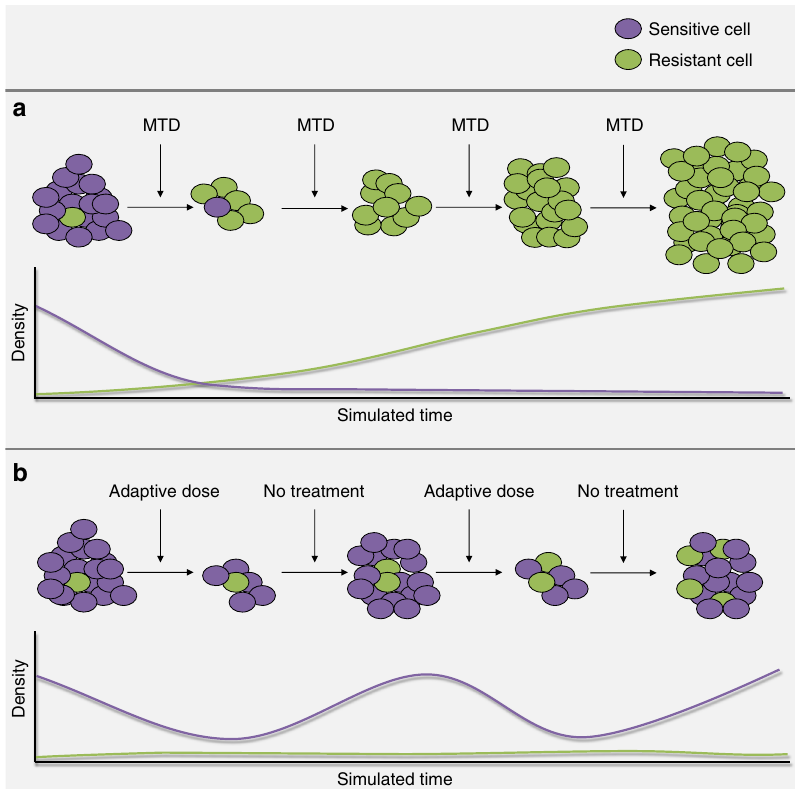
Fig. 1 Illustration of the designed evolutionary dynamics in adaptive therapy. a , b The purple cells are sensitive to the treatment and the green cells are resistant. The graphs represent the simulated density of each population over time during treatment. The top row represents standard therapy in which the maximum tolerated dose is given continuously after initiation. The cells sensitive to treatment are eliminated quickly. This intensely selects for cells that are resistant to the treatment, in this case T − cells, and eliminates the competition effects of the T+ population, resulting in competitive release with rapid treatment failure and tumor progression. The bottom row represents an evolution-based strategy in which therapy is halted before all of the sensitive cells are eliminated. In the absence of therapy, the sensitive cells out-compete the resistant cells due to their fi tness advantage. This “ steers ” the tumor back to the pretreatment so that it remains sensitive to treatment. The resistant cells, or T − population, will increase slightly with each cycle so that this treatment eventually fails. However, mathematical models demonstrate control may be durably maintained for up to 20 cycles - signi fi cantly longer than continuous